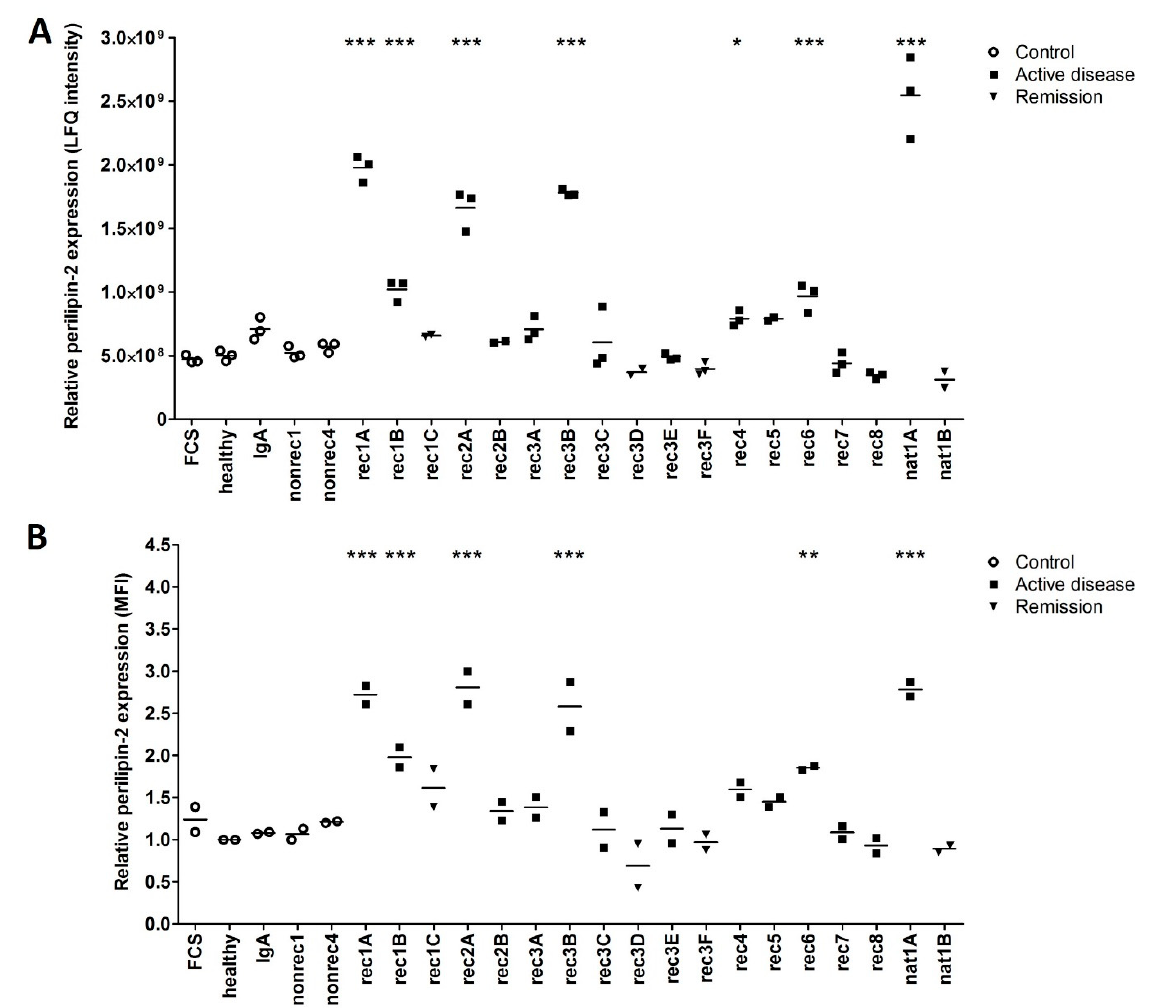
Figure 2. Increased perilipin-2 expression in hPod exposed to active disease FSGS plasmas is confirmed by flow cytometry and compared to control and remission samples. ( A ) LFQ intensities from LC–MS data of perilipin-2 are presented as individual measurements and their means. ( B ) hPod differentiated in 6-well plates (Corning) were exposed in duplicate to active disease and remission FSGS plasmas, and to (disease) control plasmas. After harvesting, cells were incubated with Alexa Fluor 488-conjugated anti-perilipin-2 antibody and analyzed by flow cytometry. Median fluorescence intensity (MFI) of two replicate experiments and their means relative to healthy plasma are depicted. Circles represent controls, squares active disease FSGS plasmas, and triangles (partial) remission plasmas. * p < 0.05, ** p < 0.01, *** p < 0.001 compared to healthy plasma. FCS: fetal calf serum; healthy: pooled plasma from five healthy donors; IgA: patient with IgA nephropathy; nat: patient with FSGS in the native kidneys; nonrec: patient with non-recurrent FSGS; rec: patient with recurrent FSGS. To validate the increased perilipin-2 protein expression in hPod as identified by